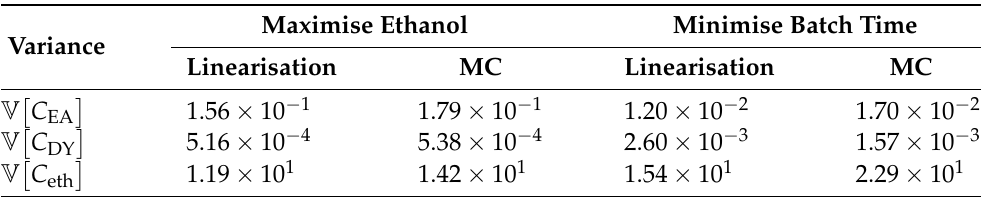
Table 6. Comparison of variances approximated using linearisation with variances approximated by Monte Carlo simulations for α =